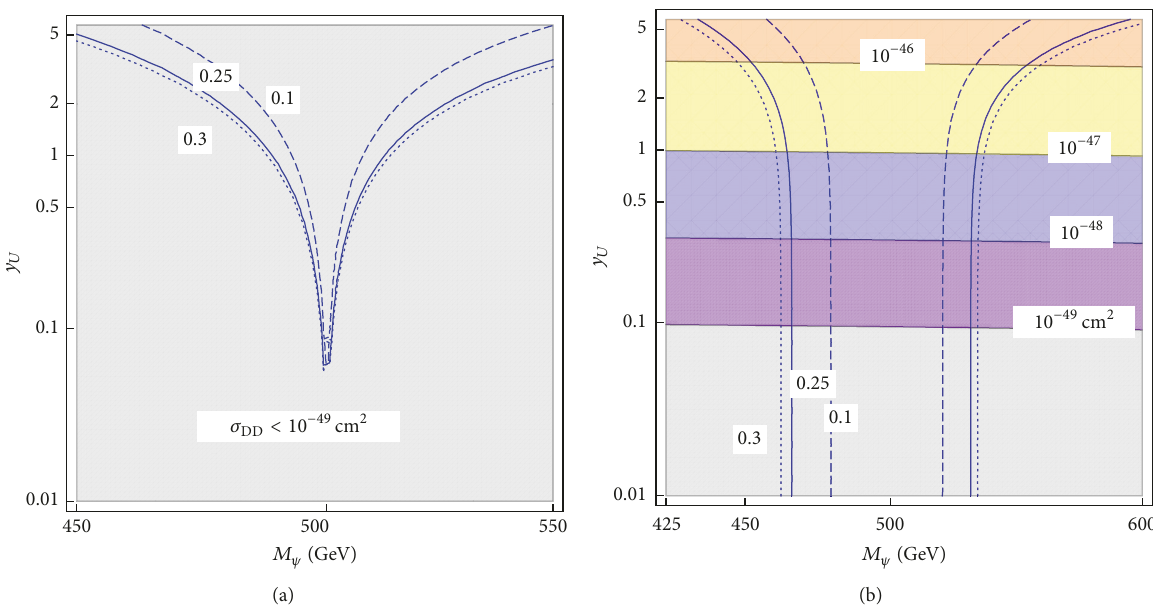
Figure 5: Contours of Ω 푑푚 = 0.1, 0.25, 0.3 , for 𝑦 휓 = 2 , 𝑀 휙 = 1000 GeV, and 𝑀 푈 = 1200 GeV, for 𝑠 ℎ = 0 (a) and 𝑠 ℎ = 0.05 (b) with the colored bands showing 𝜎 DD as marked.